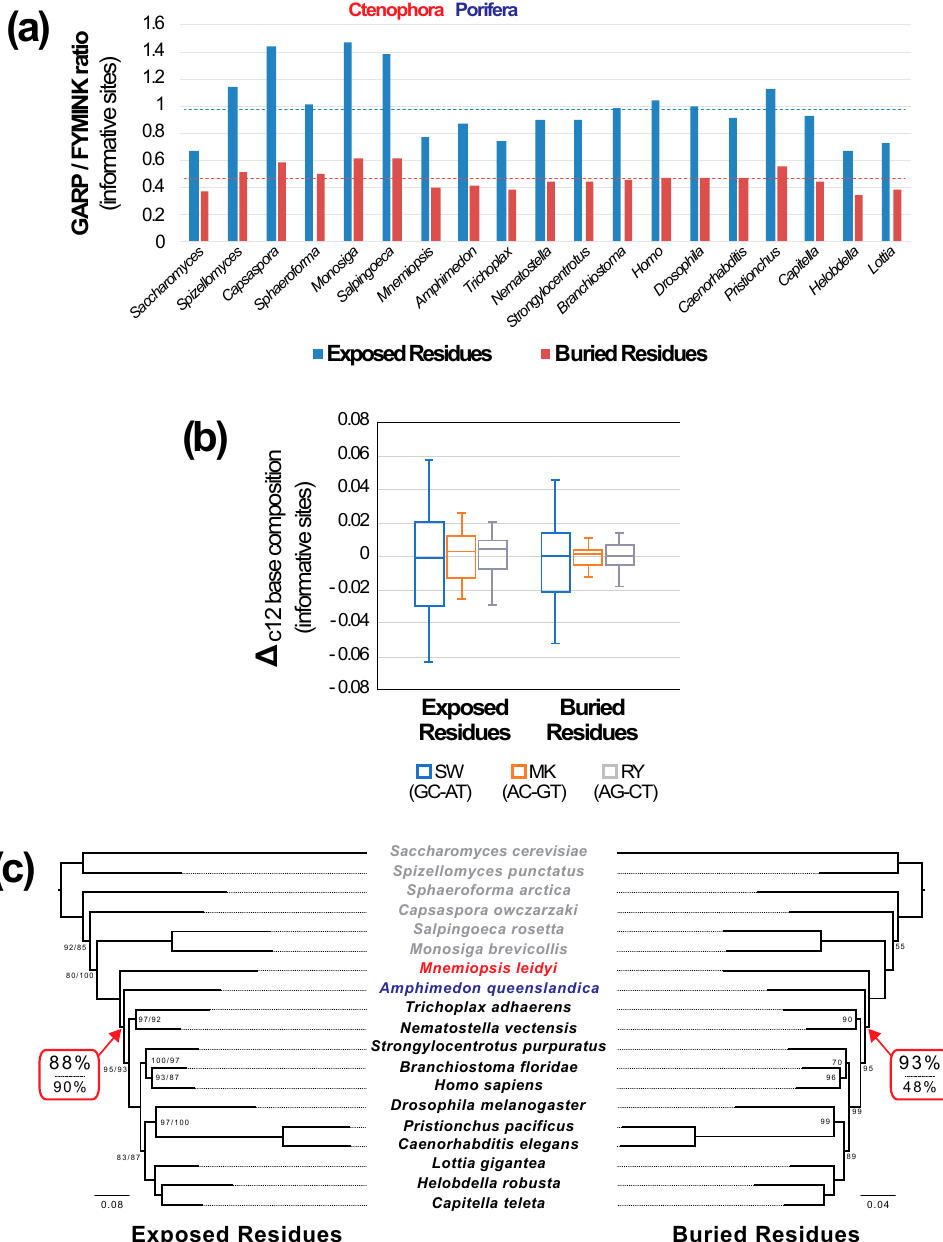
Figure 6. Compositional variation and the impact of recoding on tree estimation. ( a ) Variation across taxa in the ratio of amino acids encoded by GC-rich codons (G, A, R, and P) to those encoded by AT-rich codons (F, Y, M, I, N, and K). To limit the impact of invariant sites we only considered parsimony informative sites. ( b ) Variation in base composition for parsimony informative first and second codon positions after back translation. ( c ) The results of tree searches after recoding as binary (purine-pyrimidine (RY)) characters. The tree topologies were identical, although the tree lengths did differ (note scale bars). Support for the node that defines T2 (i.e., the node that places Ctenophora sister to other Metazoa) is emphasized using a red box; support given the binary data is presented to the top and the value for six-state Dayhoff recoding is presented below. For other nodes, bootstrap values < 100% are presented, with values for six-state recoding presented to the right. Since the trees obtained after binary and six-state coding of buried sites exhibited some topological conflicts the bootstrap support for six-state coding is not presented on that tree (except for the focal node).